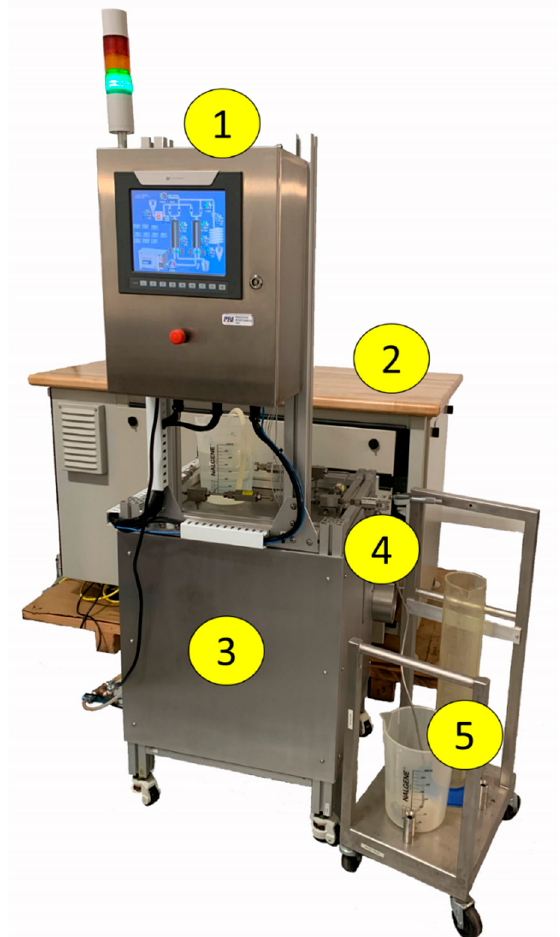
Figure 6. Industrial-scale UST homogenizer capable of continuous operation at pressure up to 400 MPa and flow rates up to 4 L/min. (1) Control system, (2) 40 horsepower, 400 MPa pump, (3) isolator enclosure, (4) UST valve, (5) output to filler.